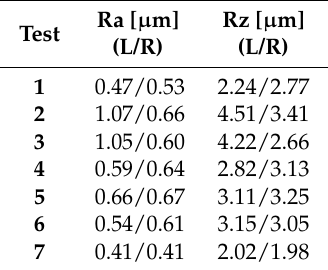
Table 9. Roughness values in profile direction of tests 1 to 7 of hard machining with standard inserts of type 1030.